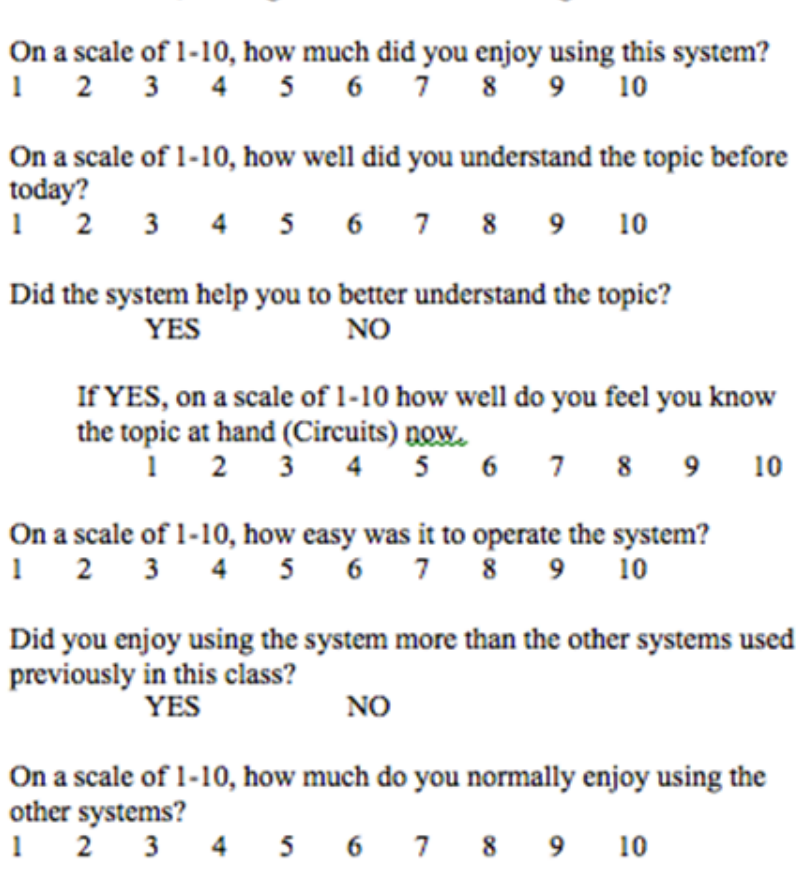
Figure 14. Surveys given to the students after the post-quiz was completed